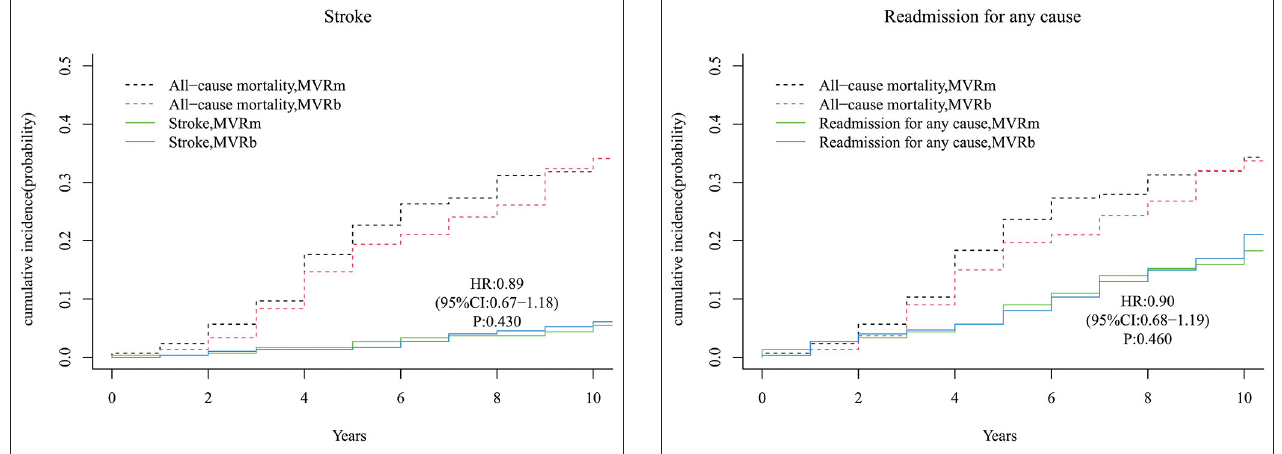
FIGURE 7 | Cumulative incidence of readmission for any cause. MVRm, mechanical mitral valve replacement; MVRb, bioprosthetic mitral valve replacement.